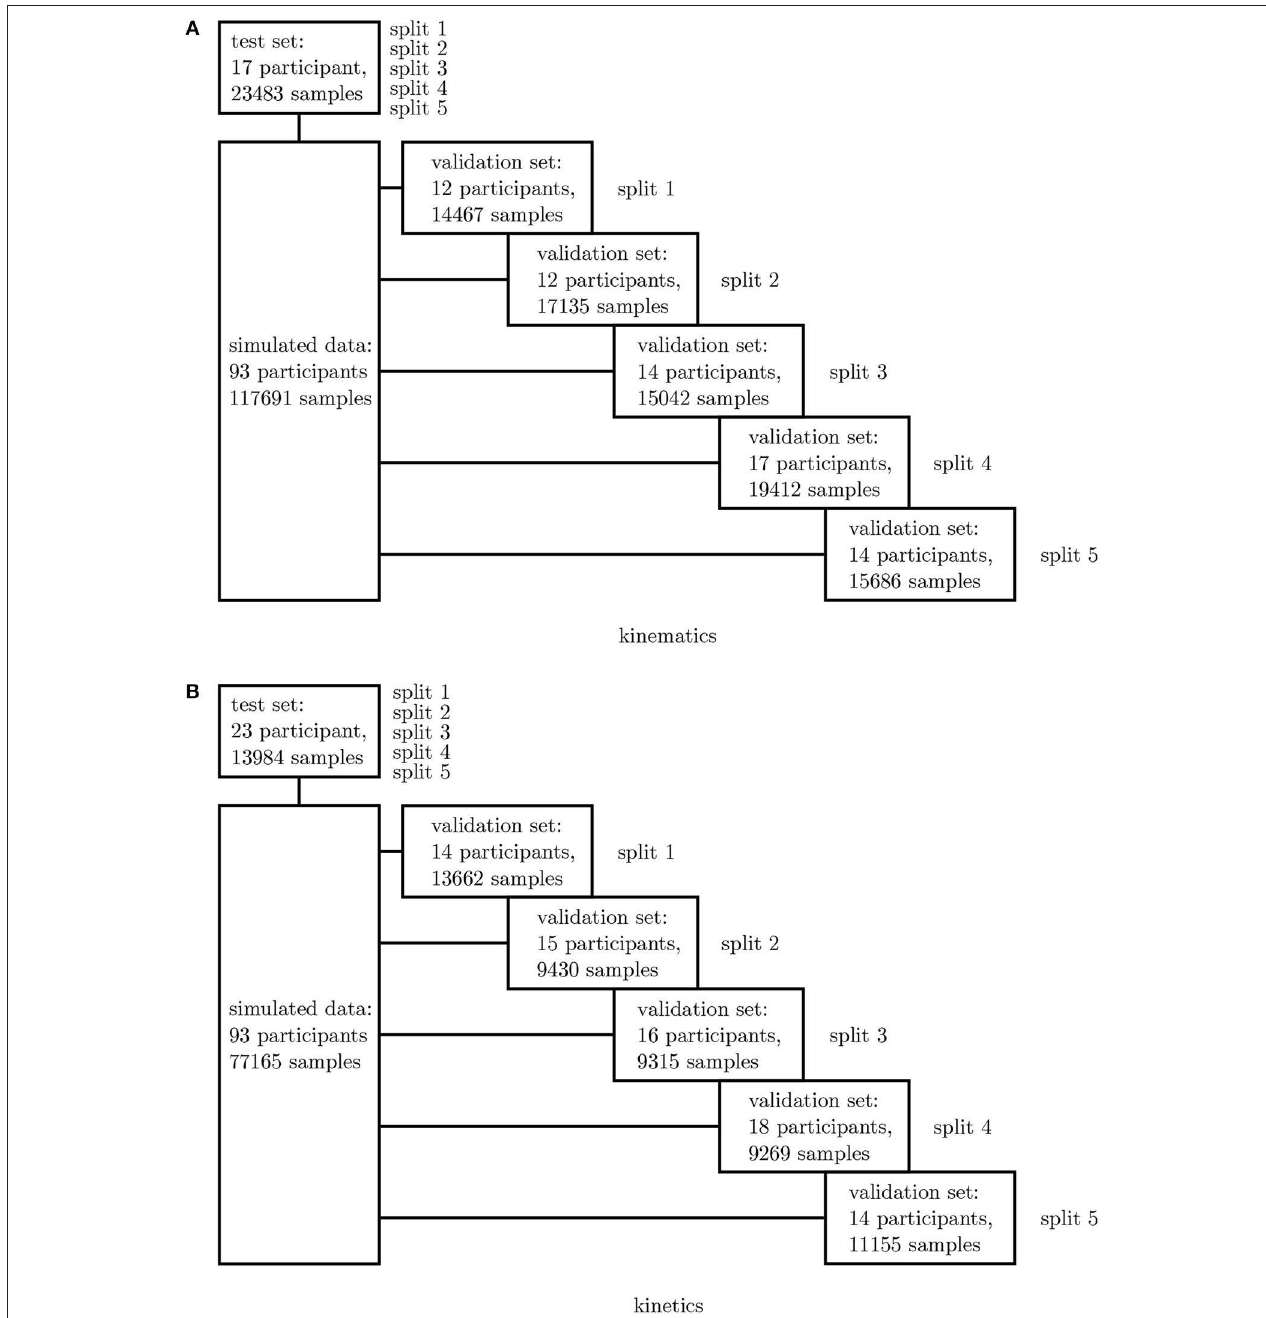
FIGURE 3 | Overview of the 5-fold cross-validation process. The dataset for the kinematics (A) and kinetics (B) differ and were treated separately.